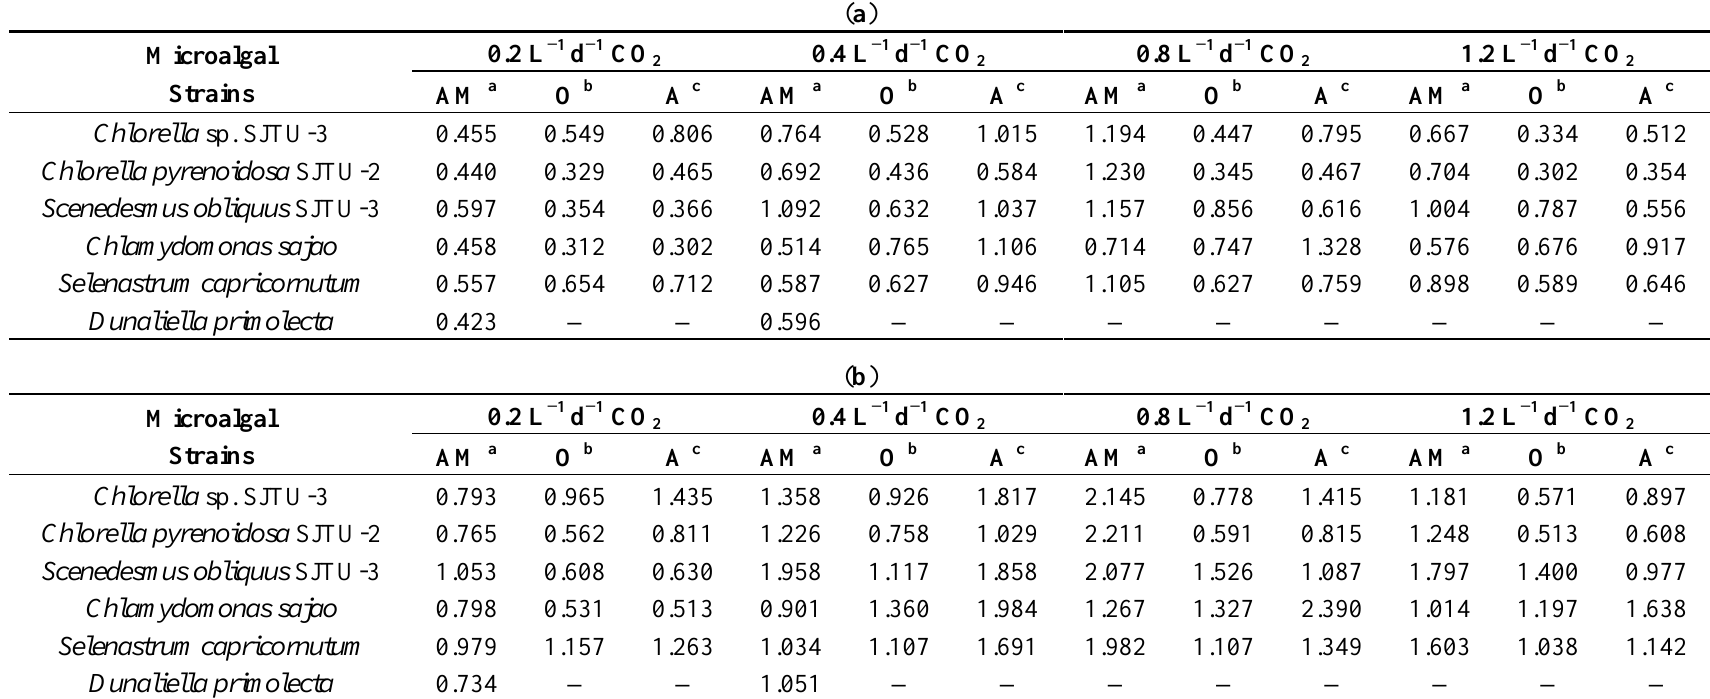
Table 2. ( a ) Cell density (g L −1 ) of 6 microalgal cultures in different media with different CO in flasks; ( b ) CO fixation (g L −1 ) of 6 microalgal cultures in different media with different CO 2 in